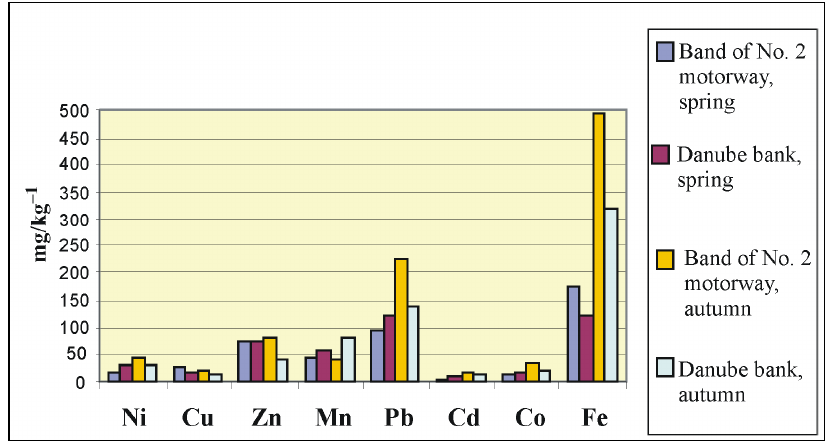
Fig. 4. Spring and autumn toxicological pollution of Plantago major in the Grove of Vác (data from